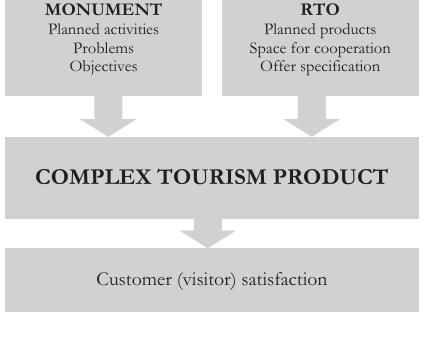
Fig. 2 - Cooperation model. Source: Own